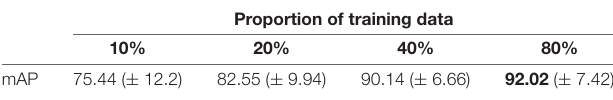
TABLE 5 | Performance is shown for both average and maximum voting